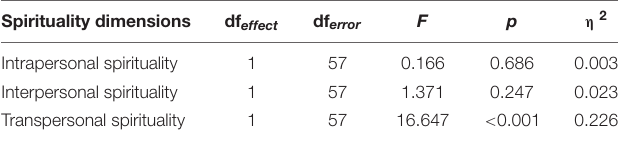
TABLE 3 | Follow-up ANOVAs for the effects of the interaction on the dimensions of spirituality. Spirituality dimensions df